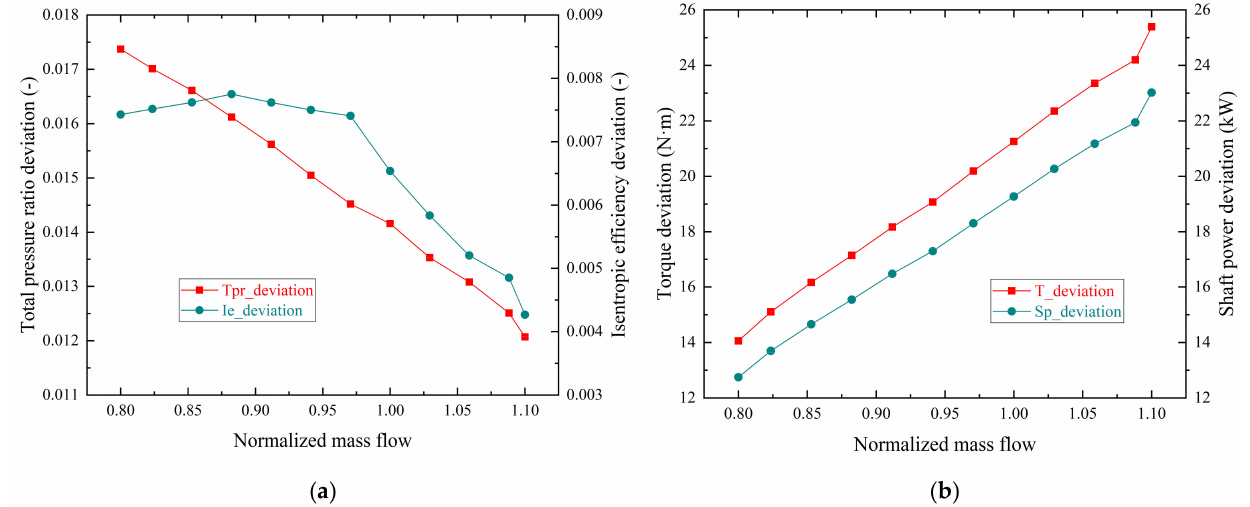
Figure 6. Effects of IBC on predicted aerodynamic performance parameters under design rotating speed: ( a ) PR t and η is ; ( b ) T and p s .